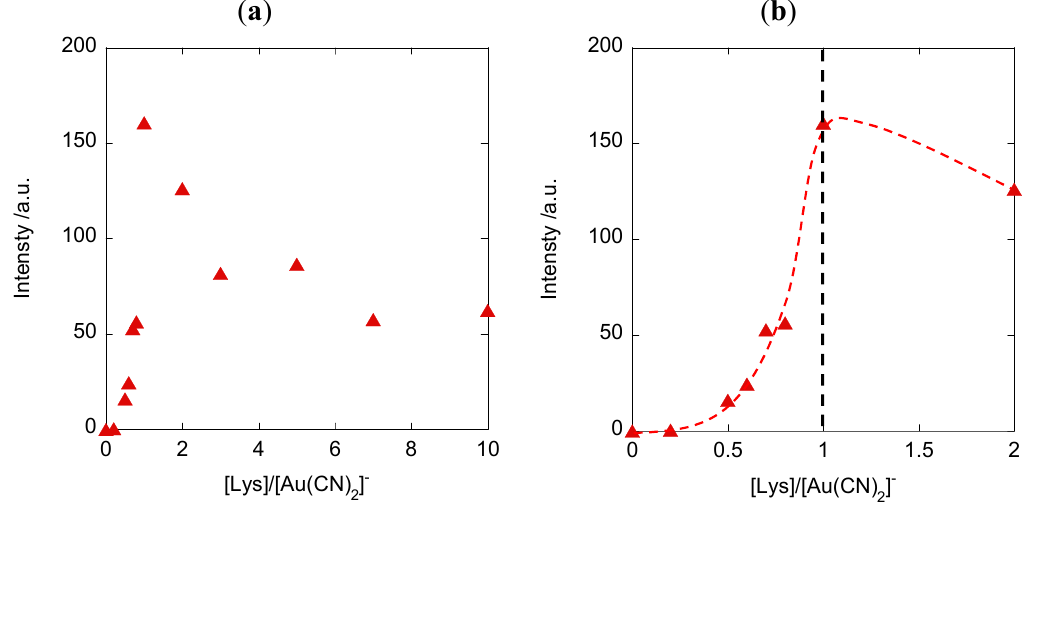
] − with changes in 2